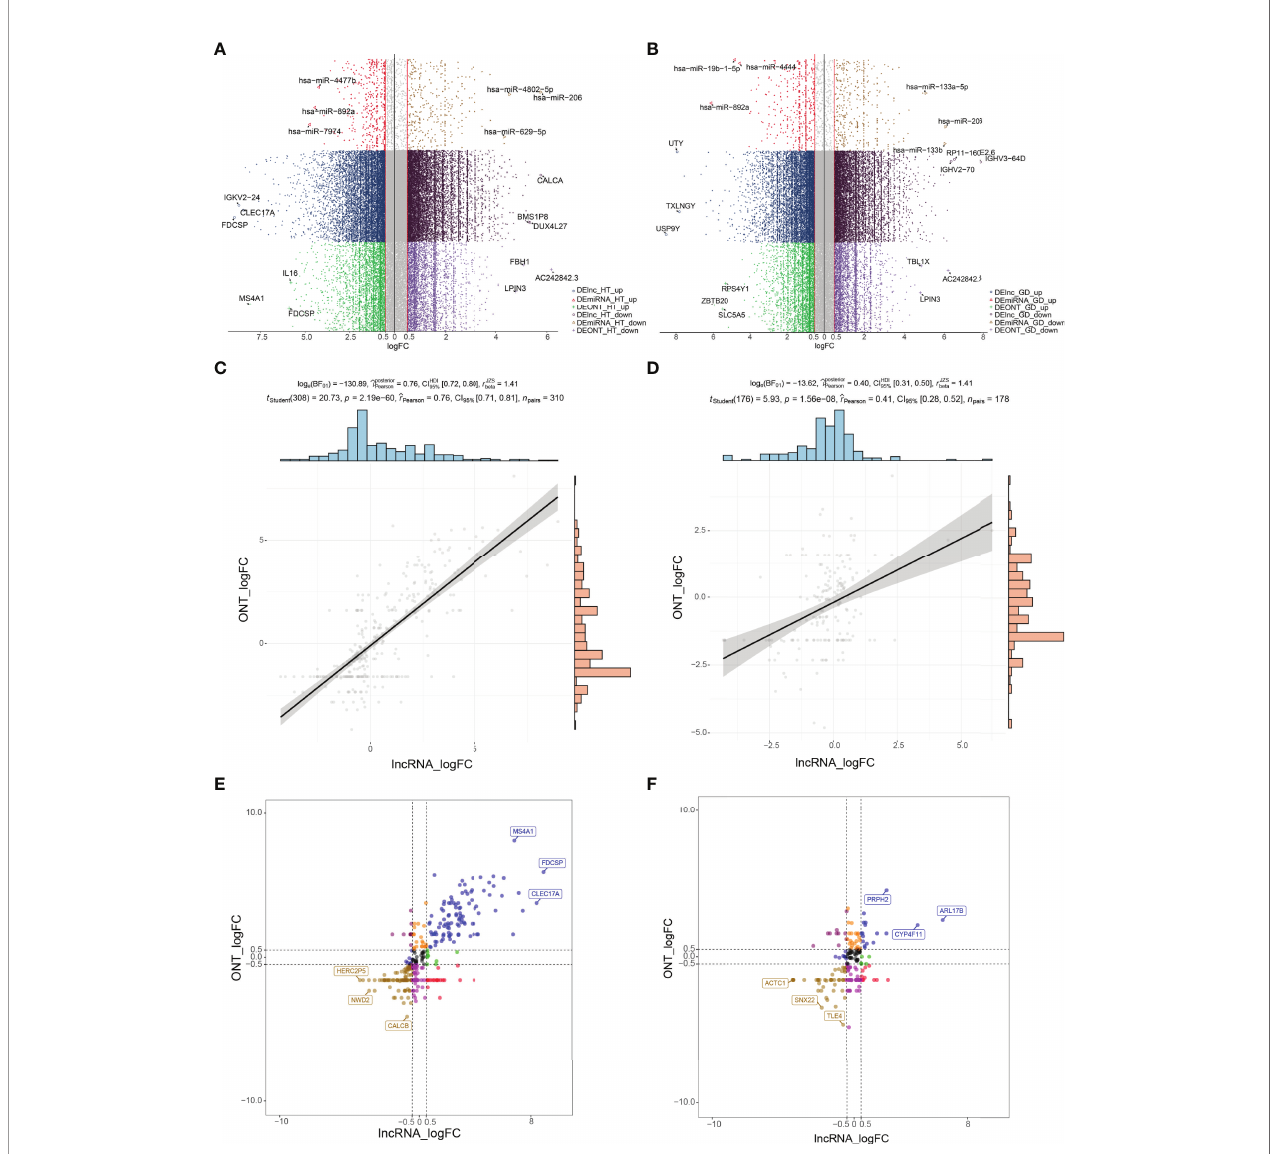
FIGURE 2 | Patterns of gene expression dysregulation in HT and GD at the bulk level. (A, B) Manhattan plot showing DElncRNAs and DEmiRNAs in ONT sequencing and RNA sequencing in HT (A) and GD (B) patients with logFC >0.5. (C, D) Correlation scatter plot demonstrating the correlation of logFC of DElncRNAs and DEmRNAs in HT (C) and GD (D) patients relative to controls in ONT sequencing and RNA sequencing, p < 0.05. (E, F) Expression dysregulated genes in HT (E) and GD (F) patients; the horizontal coordinate represents the logFC of lncRNAs in RNA sequencing, the vertical coordinate represents the logFC of lncRNAs in ONT sequencing, and the genes with logFC of both >0.5 or less than − 0.5 at the same time were selected to represent the high con fi dence expression dysregulated genes. DE, differentially expressed; GD, Graves ’ disease; HT, Hashimoto ’ s thyroiditis; logFC, log-fold change; ONT, Oxford Nanopore